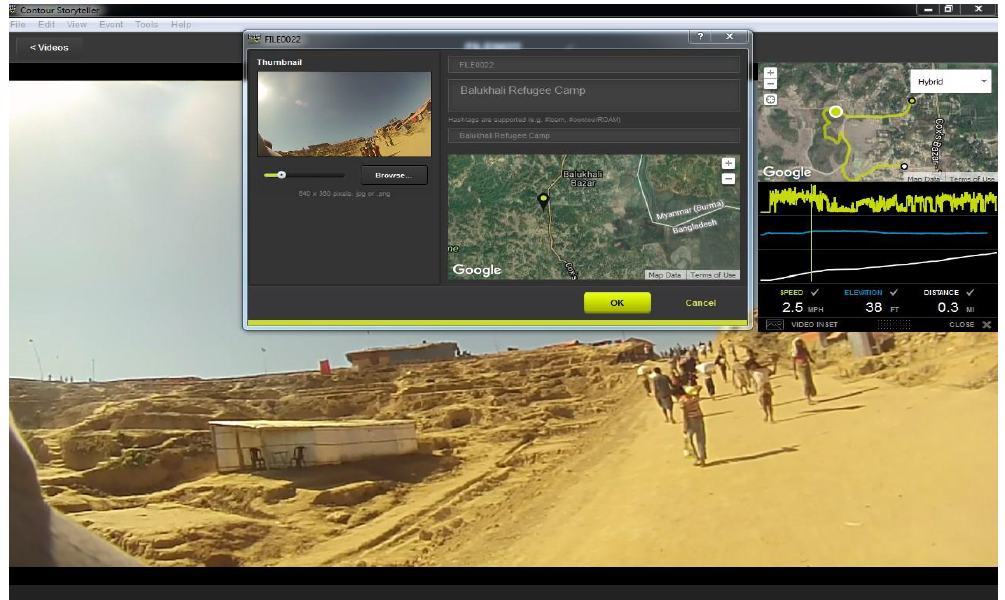
Figure 4. Refugee camps on hillslopes of Balukhali expansion site captured by high-definition spatial video camera. Inset image shows location of ground-truth training samples (left) and geographic boundary of Balukhali camp. (Source: field visit and data collection on 28 December 2017). Table 2. Description of the collected remote sensing, geospatial and socioeconomic data.